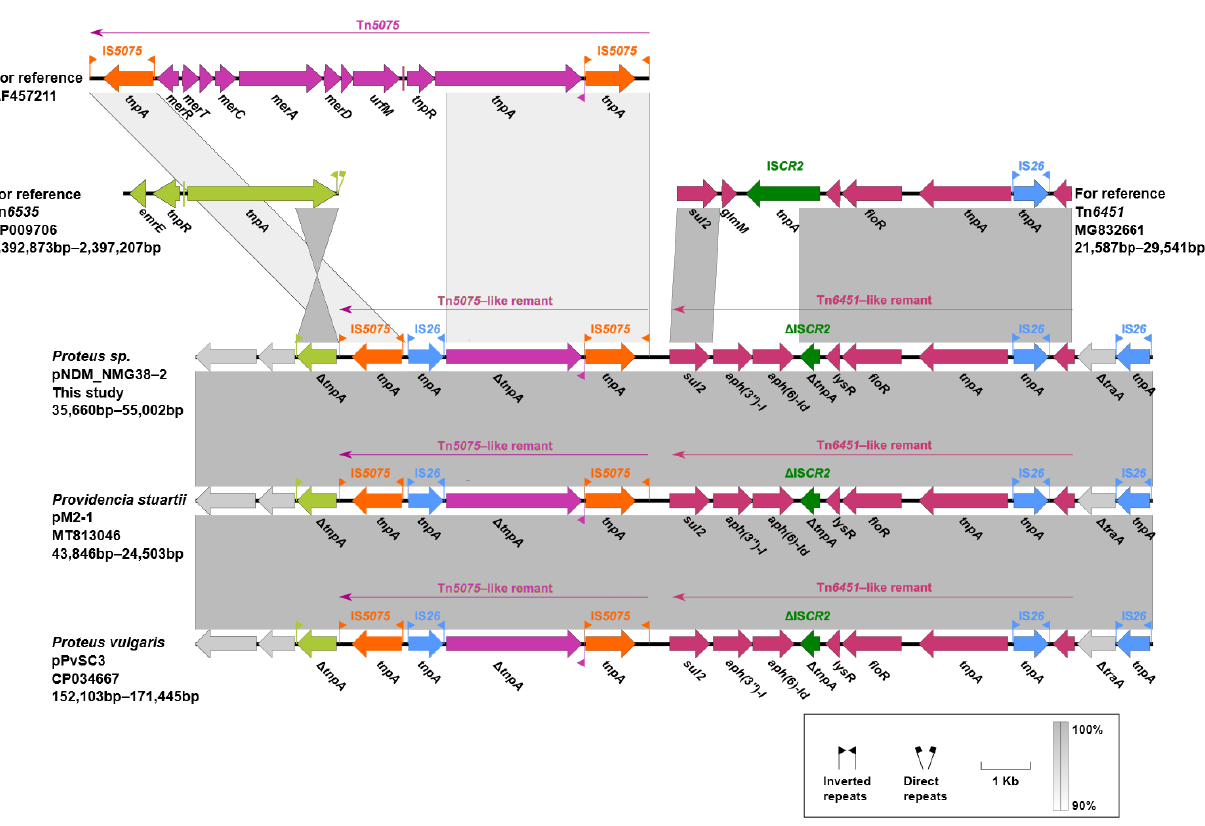
Figure 4. Organization of the MDR-1 of pPvSC3-like plasmids and comparison to related regions. Genes are denoted by arrows. Genes, mobile elements, and other features are colored based on their functional classification. Gray shading denotes regions of shared homology ranging from 90% to 100%. ∆ represents truncated genes or mobile genetic elements.